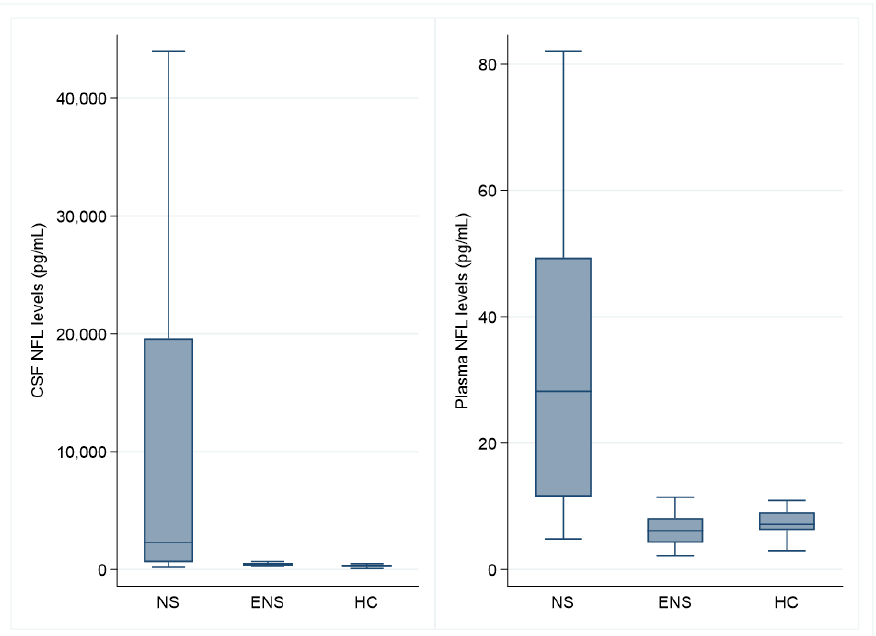
Figure 1. Box plot (Tukey method, without outliners) of neurofilament light chain levels in cere- brospinal fluid and plasma. NFL: neurofilament light chain, CSF: cerebrospinal fluid, NS: neuro- sarcoidosis patients ( n = 20), ENS: extra-neurologic sarcoidosis patients ( n = 7 in CSF and n = 20 in plasma), HC: healthy controls ( n = 11). Table 2. NFL levels in CSF and plasma related to contrast-enhancing lesions on MRI. No